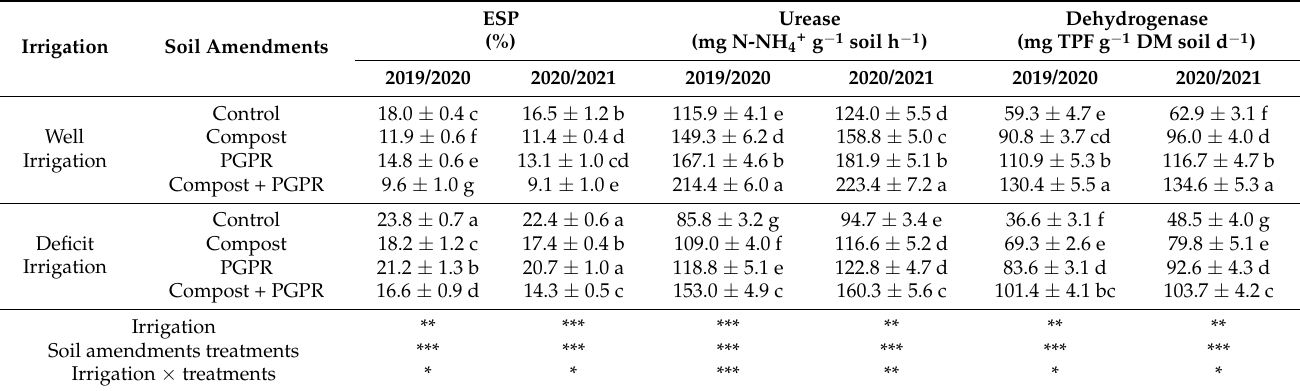
Table 1. Influence of soil amendment with compost and plant growth-promoting rhizobacteria (PGPR) on the exchangeable Na percentage (ESP), and the activity of urease and dehydrogenase in the soil cultivated with wheat plants and subjected to deficit irrigation in contrast to well